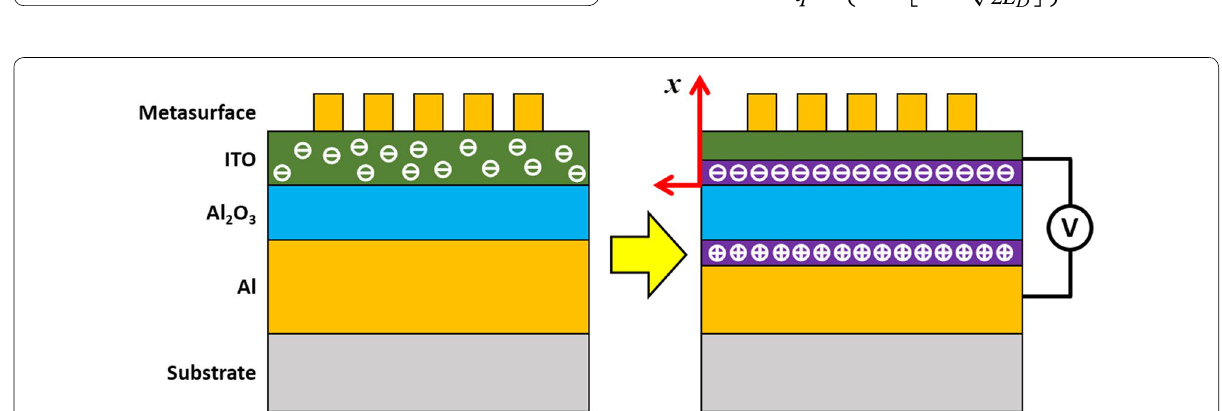
Fig. 2 Illustration of carrier movement inside ITO under voltage bias. Free electrons in the ITO layer accumulate near the interface of ITO and Al 2 O 3 . Accumulated carrier concentration decreases exponentially as distance from the interface increases. Direction x represents a reference coordinate to describe carrier density along to the depth of the ITO layer in Fig.